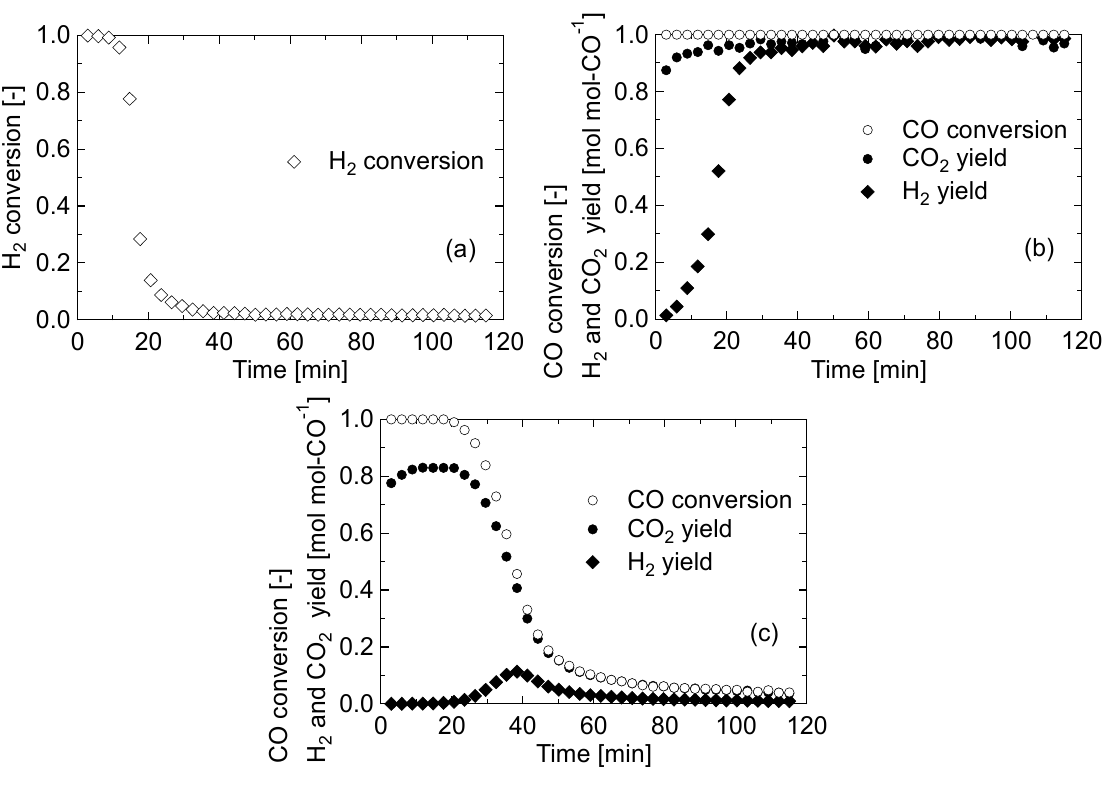
O (3 wt% Au, calcined at 200 °C) as 2 3 and H ; pre-reduction at 140 °C by ( a ) H 2 2